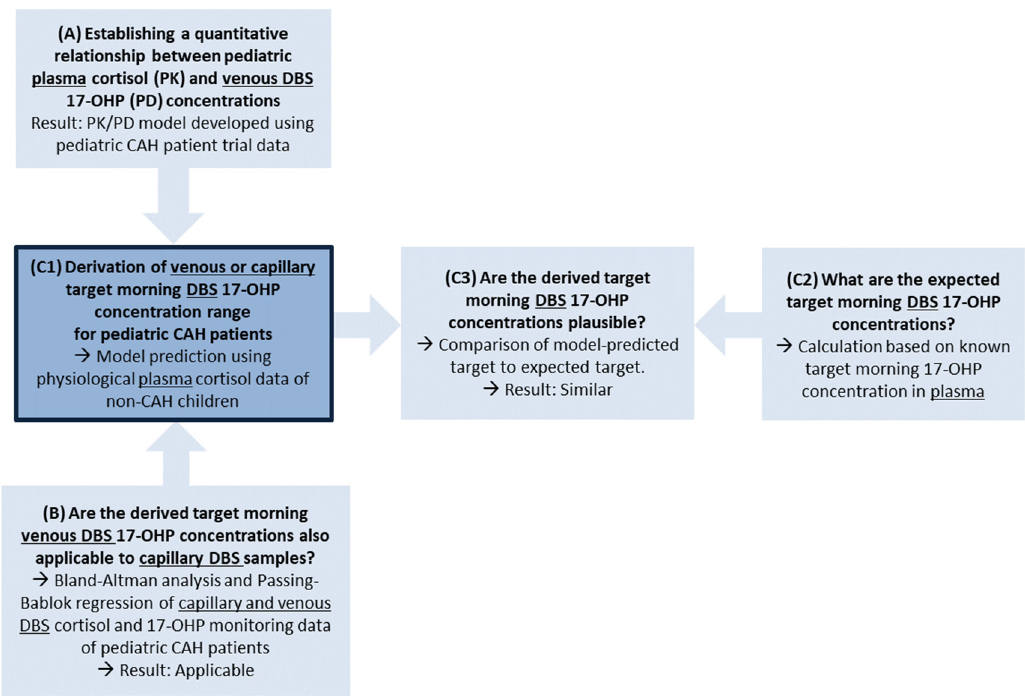
Figure 1. Modeling and simulation framework to derive target morning concentration range for the biomarker 17 α -hydroxyprogesterone (17-OHP) sampled from dried blood spots (DBS) in pediatric congenital adrenal hyperplasia (CAH) patients in clinical routine.For the goal of this analysis, the derivation of the target range (dark blue box C1), a pharmacokinetic/pharmacodynamic (PK/PD) model, quantitatively linking plasma cortisol and venous DBS 17-OHP, was developed (A). The applicability of the derived target range, which was based on venous DBS data, to capillary DBS sampling was shown in a Bland–Altman analysis and Passing–Bablok regression (B). To check for plausibility (C3), the derived target range was compared to a calculated expected DBS 17-OHP target range (C2).